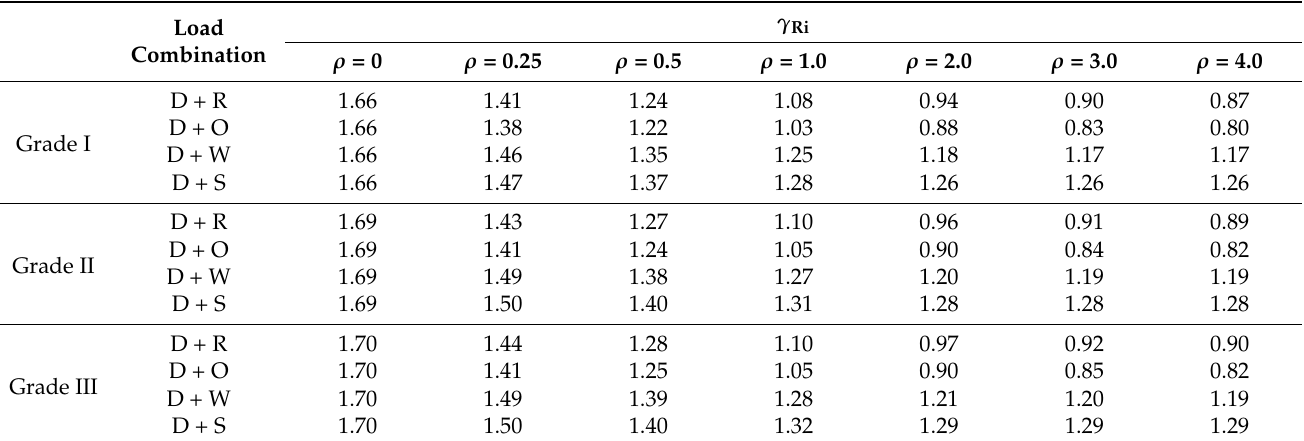
Table 3. Partial factors for resistance under target reliability γ Ri .